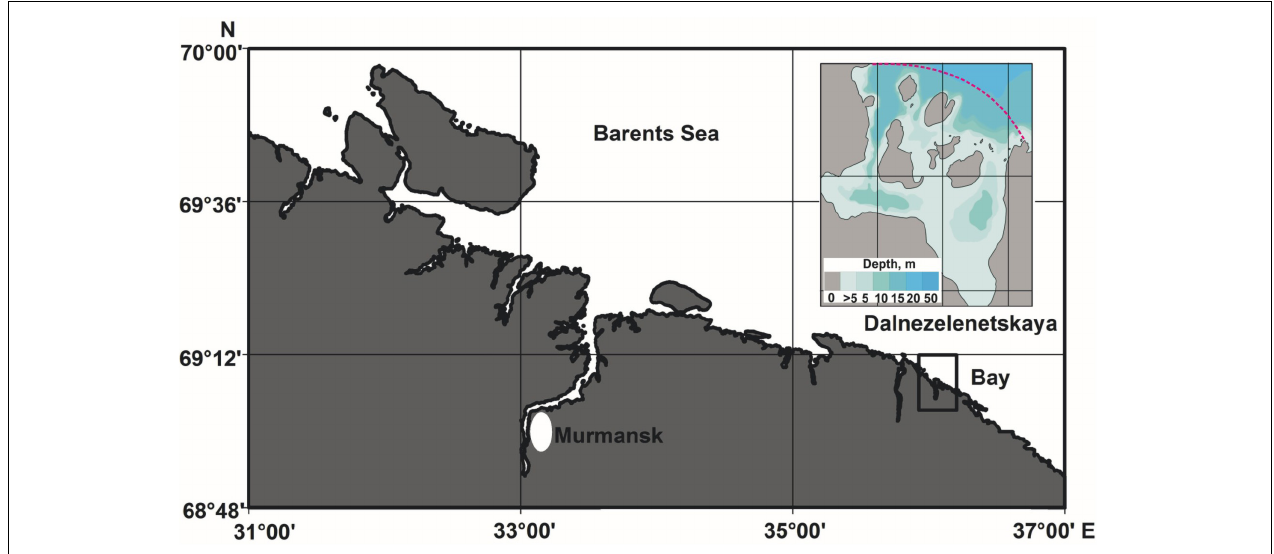
FIGURE 1 | Map of study area showing location of Dalnezelenetskaya